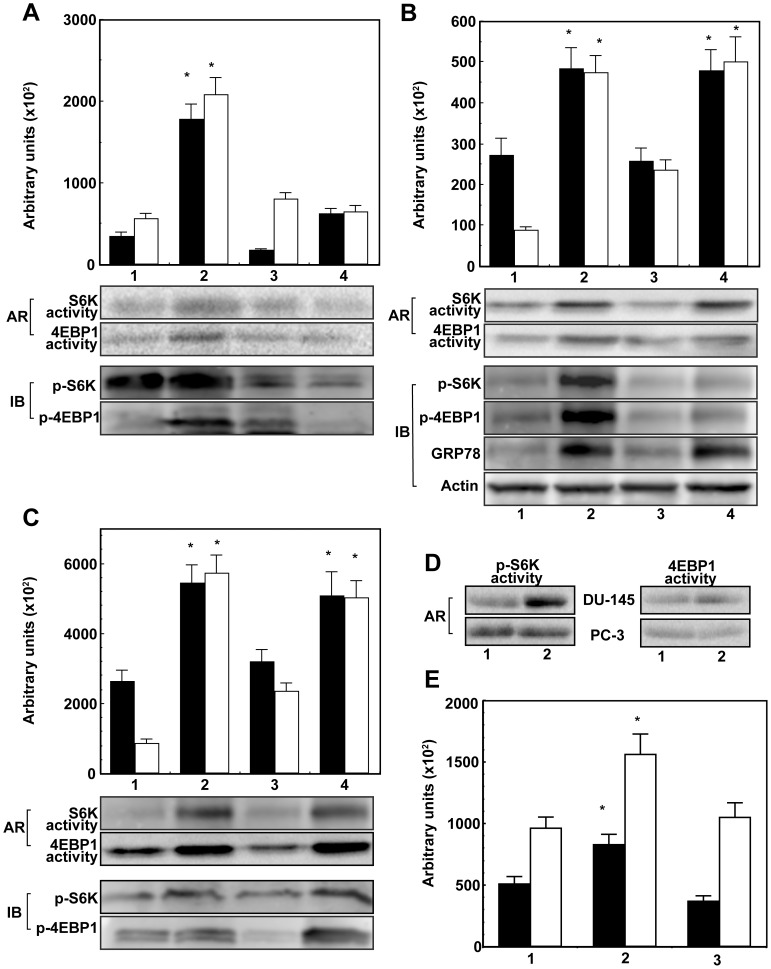
α2M*-induced activation of mTORC1 as measured by phosphorylation of S6 Kinase (▪) and 4EBP1 (□) in prostate cancer cells.The phosphorylation of S6-Kinase and 4EBP1 was determined by [33P]-γ-ATP incorporation and autoradiography (AR) and by immunoblotting (IB). Panel A. A bar diagram showing α2M*-induced activation of mTORC1 and its modulation by LY294002 and rapamycin in mTOR immunoprecipitates as determined by autoradiography. The bars and lanes in the autoradiographs are: (1) buffer; (2) α2M* (50 pM/25 min); (3) LY294002 (20 µM/20 min) then α2M* (50 pM/25 min); and (4) rapamycin (100 nM/15 min) then α2M* (50 pM/25 min). A representative autoradiograph (AR) of three individual experiments is shown below the bar diagram. The phosphorylation of S6-Kinase (▪) and 4EBP1 (□) is expressed in arbitrary fluorescence units and is the mean ± from three independent experiments. Also shown below AR is a representative immunoblot (IB) of three experiments of p-S6-Kinase and p-4EBP1 obtained from mTOR immunoprecipitates of cells treated as in autoradiographic analysis in Panel A. Panel B. A bar diagram showing the effect of silencing GRP78 expression by RNAi on α2M*-induced activation of mTORC1 in mTOR immunopreciptates in 1-LN cells as determined by autoradiography. The bars and the lanes in the autoradiograph (AR) are: (1) lipofectamine + buffer; (2) lipfectamine + α2M (50 pM/25 mins); (3) GRP78 dsRNA (100 nM/48h) then α2M* (to pM/25 min); and (4) scrambled dsRNA (100 nM/48h) than α2M* (to pM/25 min). A representative autoradiograph of S6-Kinase (▪) and 4EBP1 (□) of three experiments is shown below the bar diagram. The phosphorylation of S6-Kinase (▪) and 4EBP1 (□) is expressed in arbitrary fluorescence units as mean ± SE from three independent experiments. Also shown below the autoradiograph (AR) is a representative immunoblot (IB) of p-S6-Kinase and p-4EBP1 obtained from mTOR immunoprecipitates of 1-LN cells treated as in autoradiographic analysis in Panel B. An immunoblot representative of three experiments showing the expression of GRP78 in cells transfected with GRP78 dsRNA is also shown. The lanes in the immunoblot are: (1) lipofectamine + buffer; (2) lipofectamine + α2M* (50 pm/25 min); (3) GRP78 dsRNA (100 nM/48h) + α2M*; and (4) scrambled dsRNAi (100 nM/48h) + α2M*. Panel C. A bar diagram showing the effect of silencing GRP78 expression by RNAi on α2M*-induced phosphorylation of S6-Kinase (▪) and 4EBP1 (□) in Raptor immunoprecipitates of 1-LN cells as determined by autoradiography. The bars and lanes in the autoradiograph (AR) are identical to the bar diagram and autoradiograph in Panel B. A representative autoradiograph (AR) of S6-Kinase and 4EBP1 of three experiments is shown below the bar diagram. The phosphorylation of S6-Kinase (▪) and 4EBP1 (□) is expressed in arbitrary fluorescence units as the mean ± SE from three experiments. Also shown below the autoradiograph (AR) is a representative immunoblot (IB) of three experiments of p-S6-Kinase and p-4EBP1 obtained from Raptor immunoprecipitates of 1-LN cells treated as in the autoradiographic analysis in Panel C. Panel D. Autoradiograph showing α2M*-induced phosphorylation of S6-Kinase and 4EBP1 in DU-145 prostate cancer cells but not in PC-3 prostate cancer cells. The lanes in the autoradiograph are: (1) buffer; (2) α2M*. For details see "Experimental Procedures" section. The autoradiograph shown is representative of four experiments. Panel E. A bar diagram showing that antibodies against the carboxyl-terminal domain of GRP78 inhibit α2M*-induced phosphorylation of S6-Kinase (▪) and 4EBP1 (□) in mTOR immunoprecipitates of 1-LN cells. The bars are: (1) buffer; (2) α2M* (50 pM/25 min); (3) antibodies against the carboxyl-terminal domain of GRP78 (3 µg/ml/1 h) then α2M*. The phosphorylation of S6-Kinase and 4EBP1 was determined by autoradiographic analysis and is expressed in arbitrary units and is the mean ± SE from three experiments. The values significantly different at 5% for α2M* and scrambled dsRNA-treated cells are denoted by an asterisk (*) in all the Panels A to E.